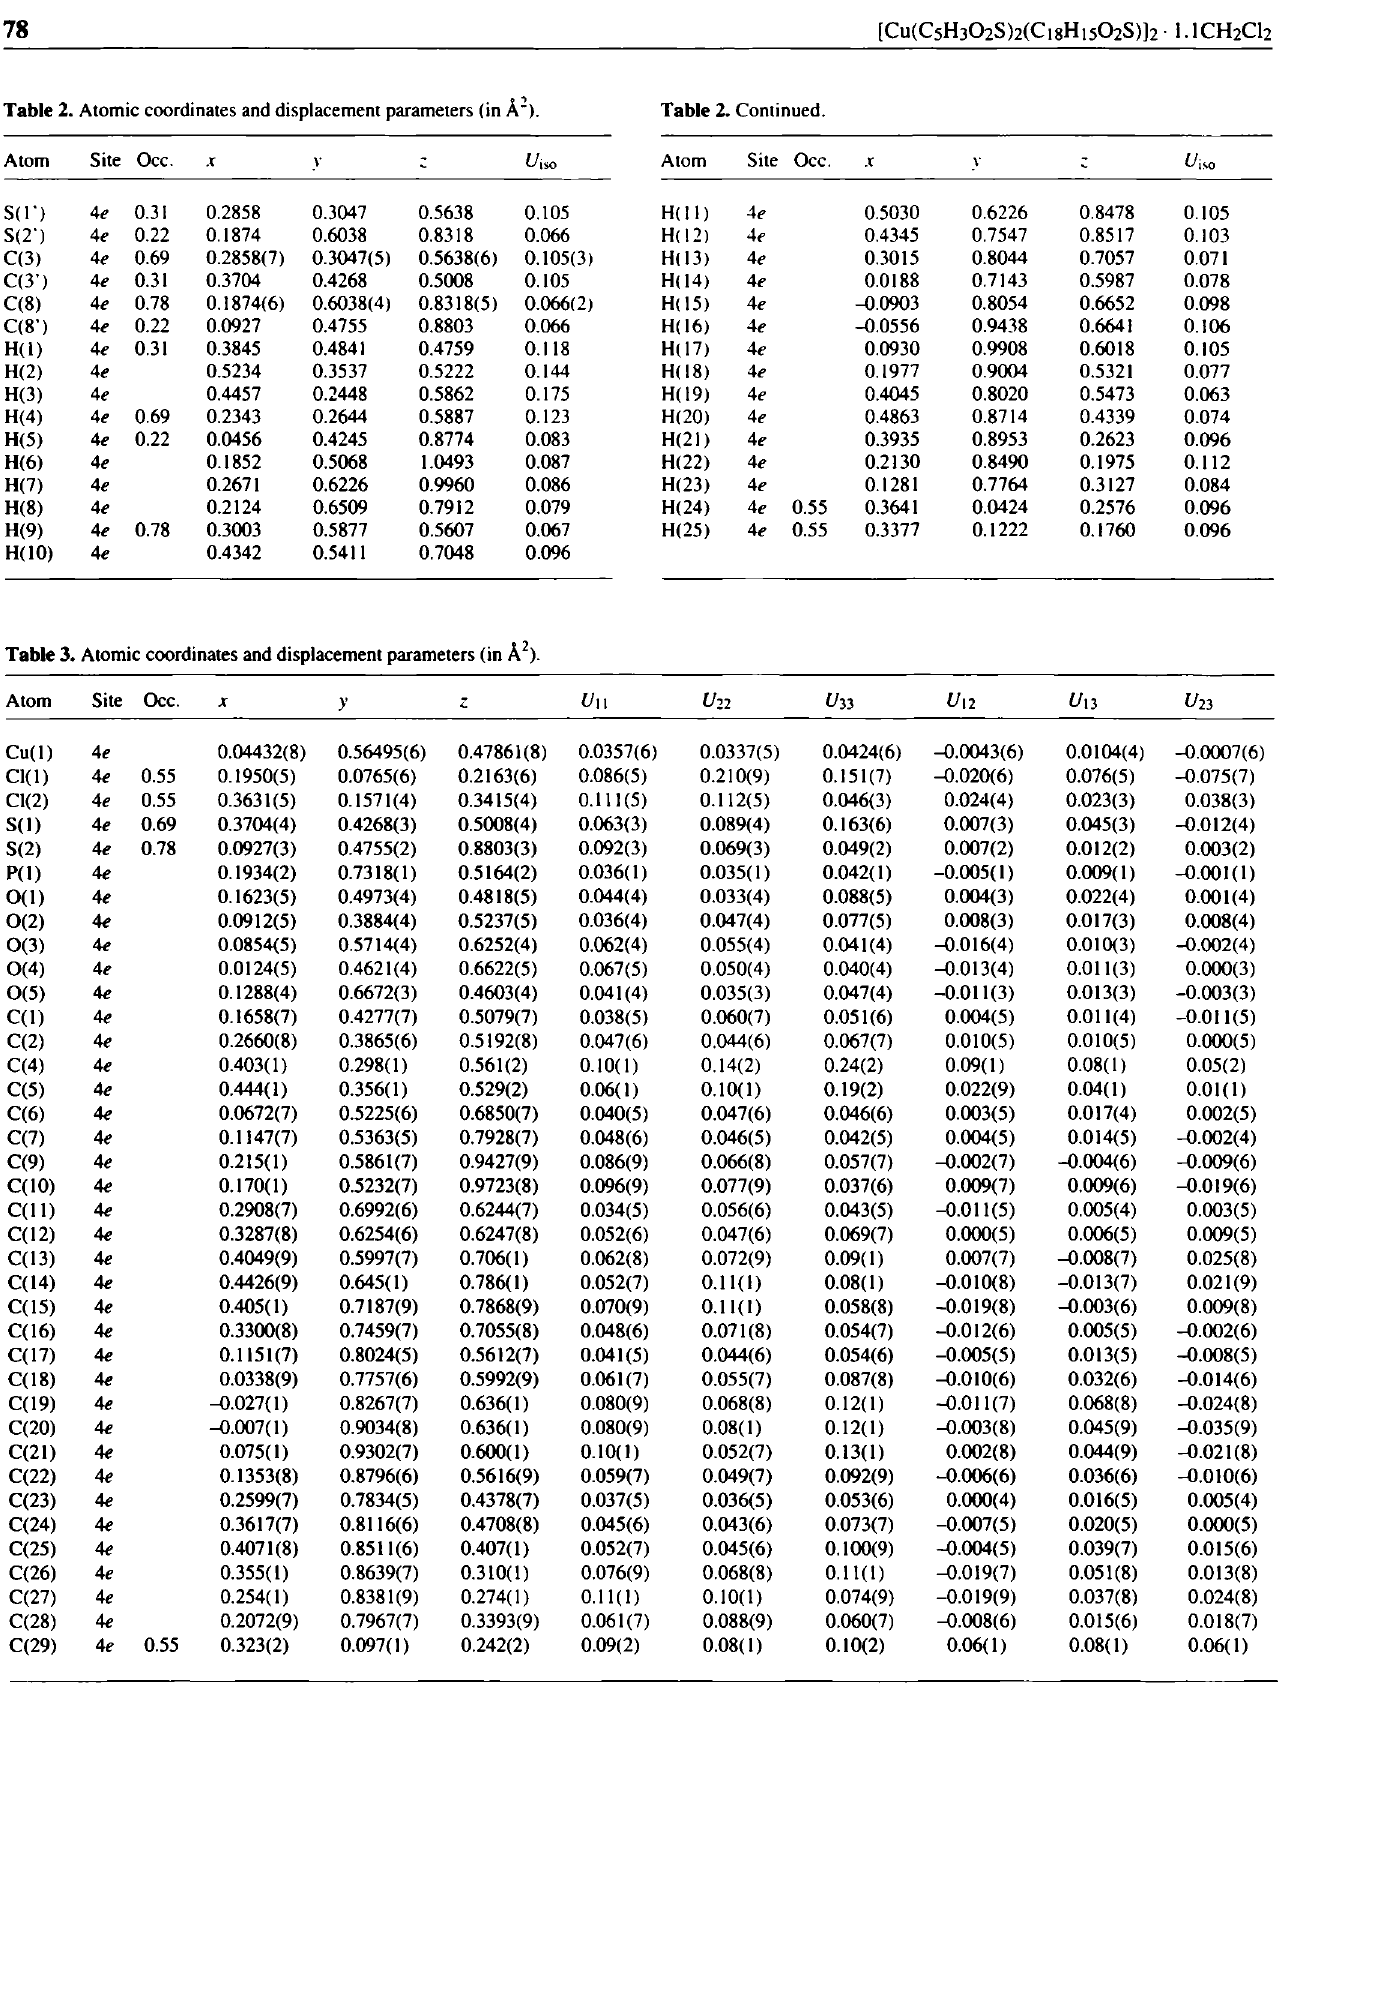
Table 2. Atomic coordinates and displacement parameters (in Ä"). Table 2. Continued.